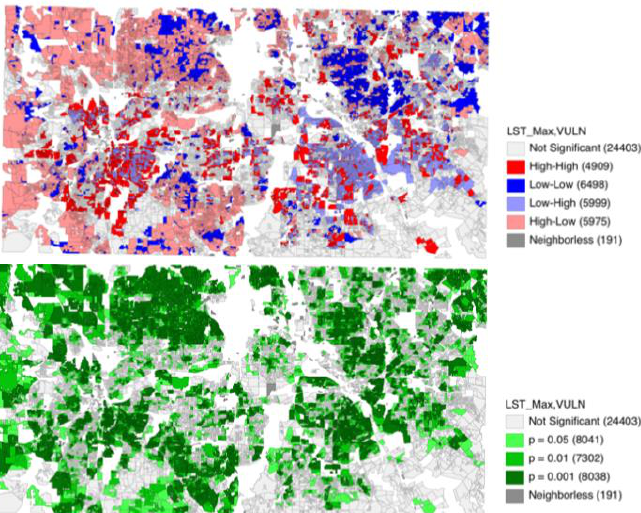
Figure 12. Bivariate Local Moran’s I spatial autocorrelation cluster and significance maps for maximum LST versus socio- economic vulnerability for